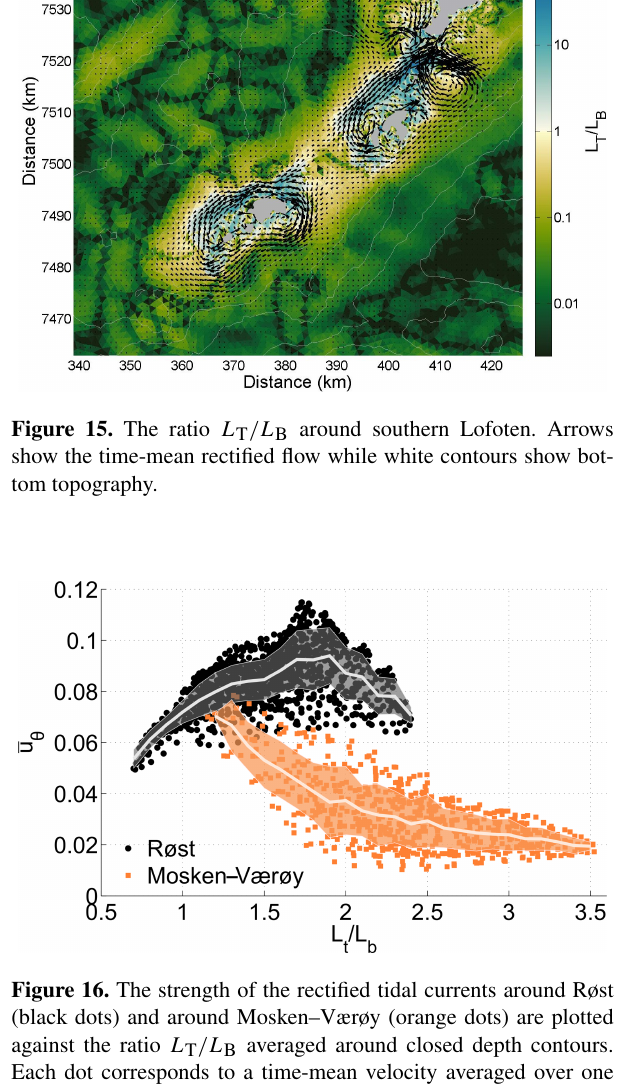
Røst, residual currents attain a maximum for L T /L B ∼ 1 .